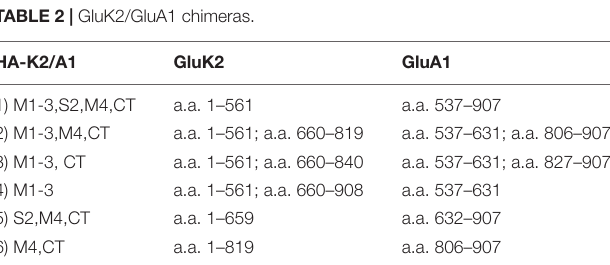
TABLE 2 | GluK2/GluA1 chimeras.